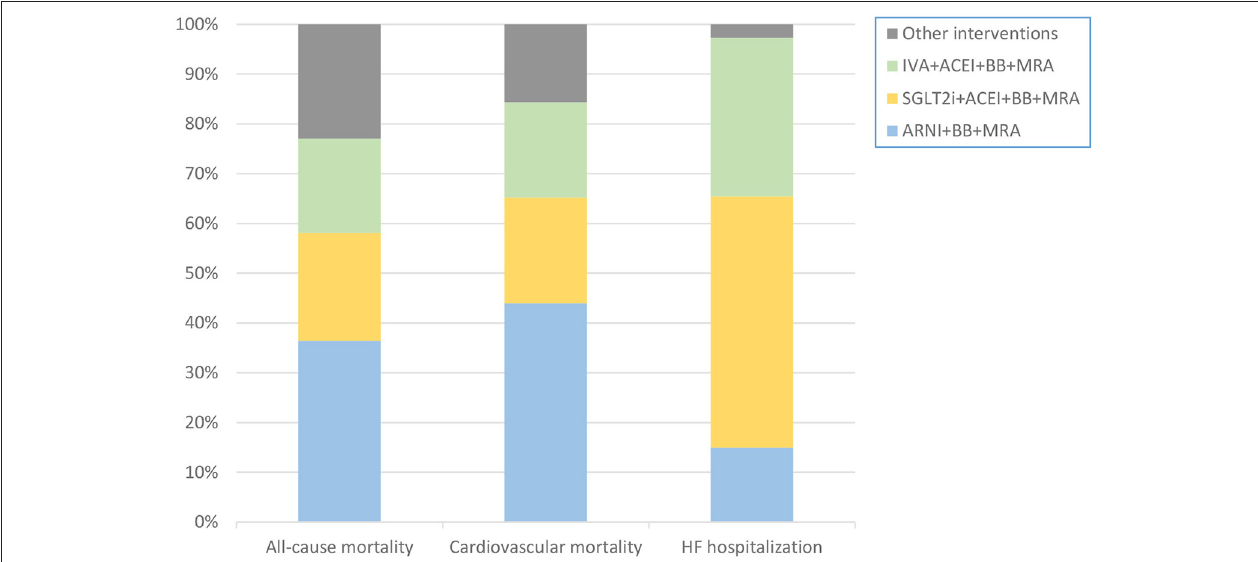
FIGURE 5 | Stacking histogram showing probability that each intervention is the best therapy in each outcome. The probability that ARNI + BB + MRA was the optimal treatment was highest in terms of reducing all-cause or cardiovascular mortality. The probability that SGLT2i + ACEI + BB + MRA was the optimal treatment was highest in terms of reducing hospitalization for HF. ACEI, angiotensin-converting enzyme inhibitor; ARNI, angiotensin receptor-neprilysin inhibitor; BB, beta-blocker; HF, heart failure; IVA, ivabradine; MRA, mineralocorticoid receptor antagonist; SGLT2i, sodium-glucose cotransporter 2